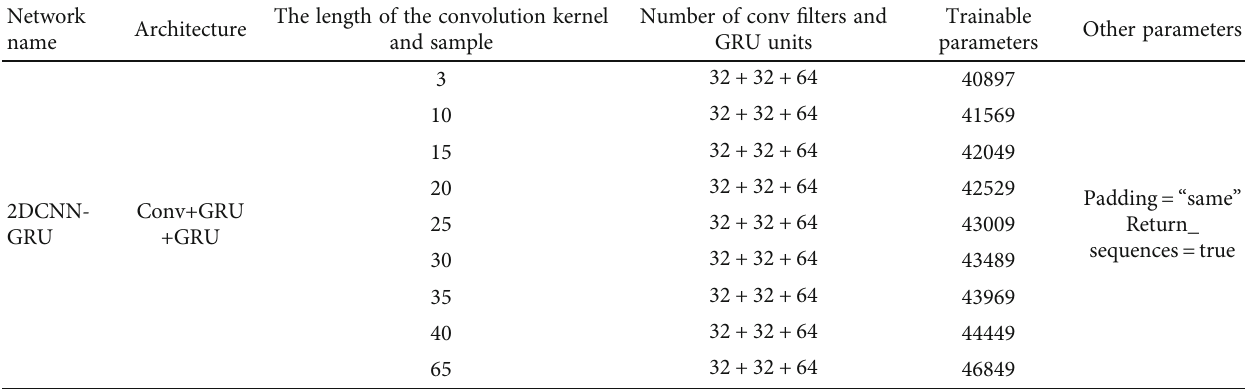
Figure 11: The evaluation metrics of 2DCNN-GRU, 2DCNN, and GRU networks. Table 2: The structures of the 2DCNN-GRU hybrid network in 9